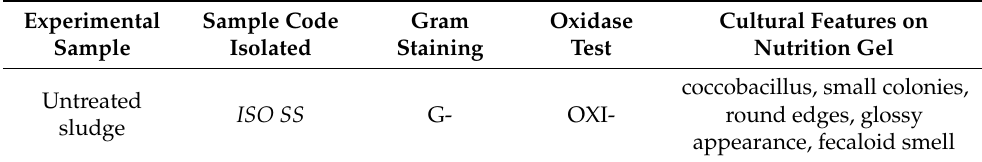
Table 4. ISO SS strain characterization.